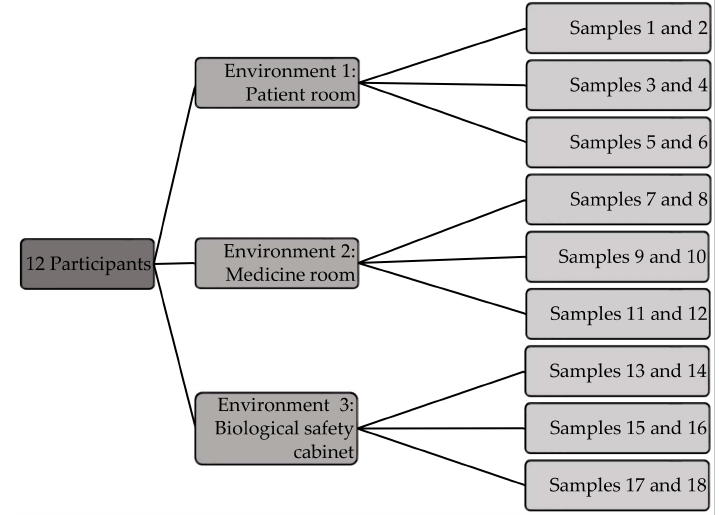
Figure 1. Compounding of parenteral product samples (N = 220). One participant compounded four extra samples to evaluate the variation in sterility within one batch.